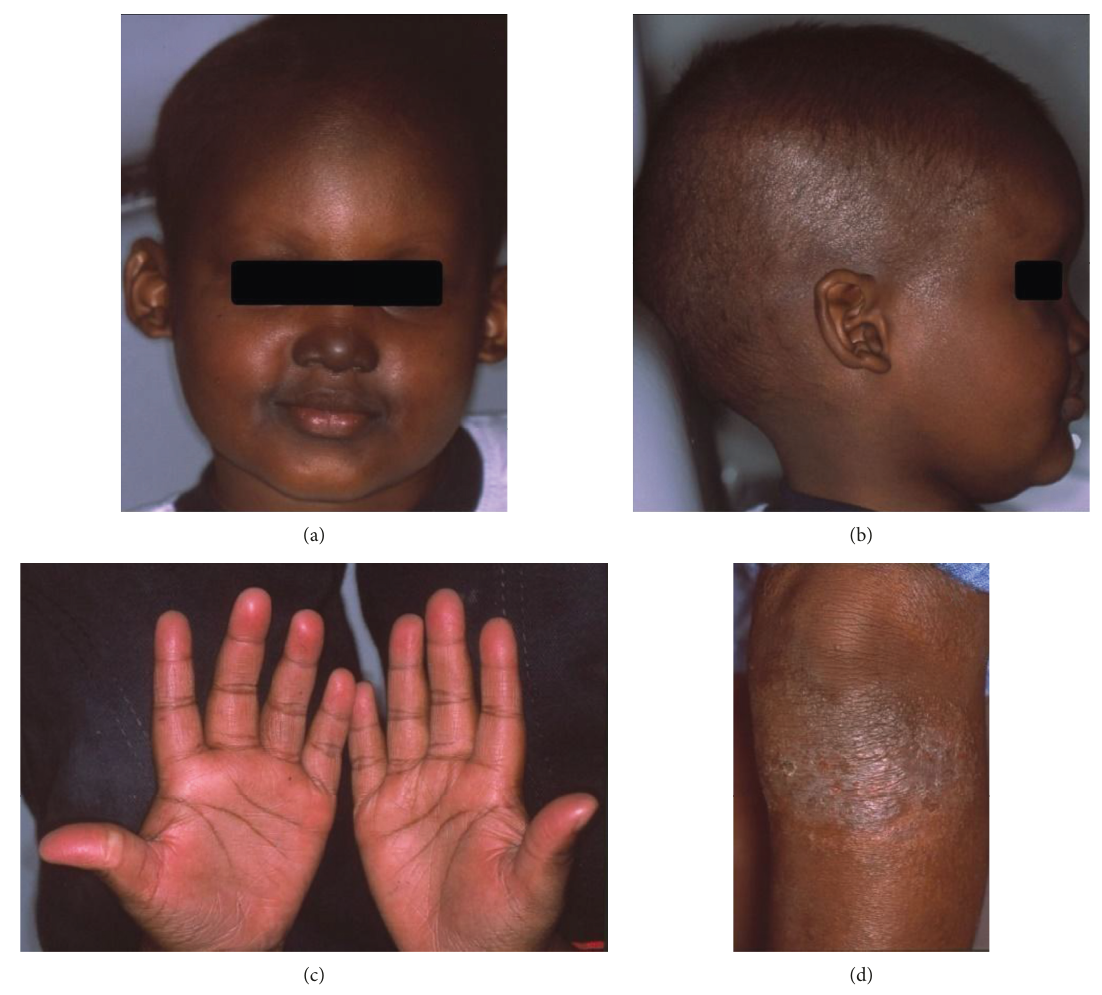
Figure 6: Patient 3. Child with hypohidrotic ED presented sparse hair, perioral and nasal pigmentation, ear deformity with pointed shape (a and b), and hyperkeratosis on the palms and knee (c and